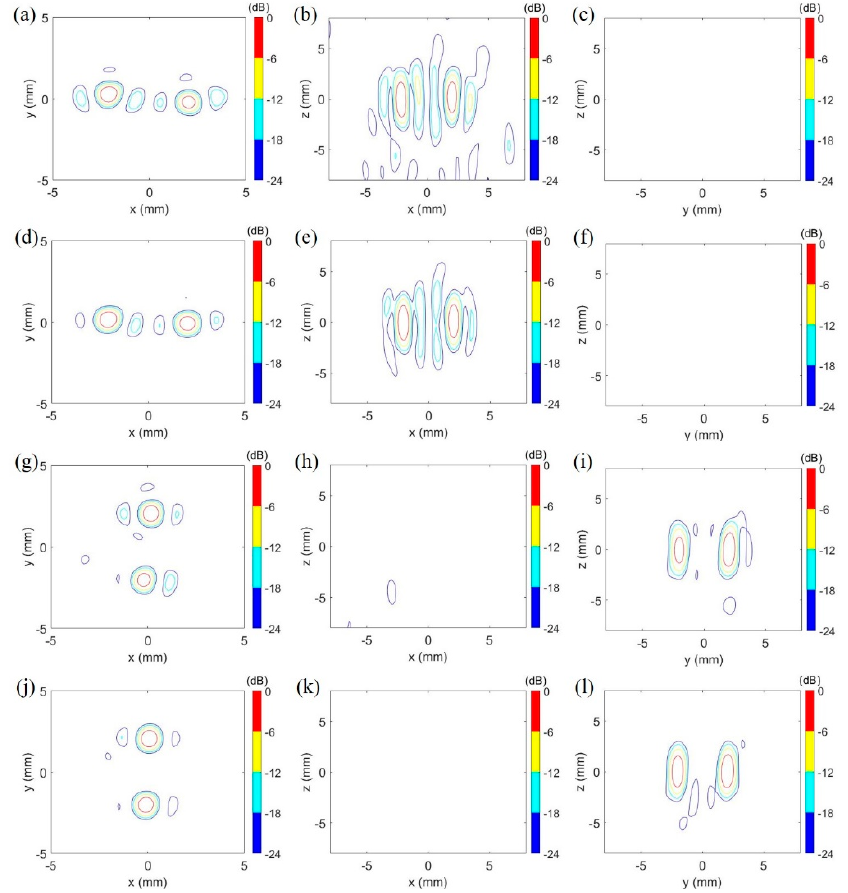
Figure 6. Focusing patterns of the 114-element and 381-element transducers with the focusing pattern 1 and the focusing pattern 2 in the simulation. ( a – f ) illustrate a pair of horizonal foci formed by the 114-element transducer and 381-element transducer with the focusing pattern 1, respectively. ( g – l ) shows the other pair of vertical foci produced by the 114-element transducer and 381-element transducer with the focusing pattern 2, respectively. The peak pressure was 9.70 MPa (no skull) & 1.95 MPa (via skull) and 9.70 MPa (no skull) & 2.18 MPa (via skull), respectively, for the focusing pattern 1 and 2 of the 114-element transducer. For the focusing pattern 1 and 2 of the 381-element transducer, the peak pressure was 8.15 MPa (no skull) & 1.63 MPa (via skull) and 8.15 MPa (no skull) & 1.82 MPa (via skull), respectively. dB: 20log (the intensity/peak intensity). Table 2. Simulated results of two focusing patterns for two